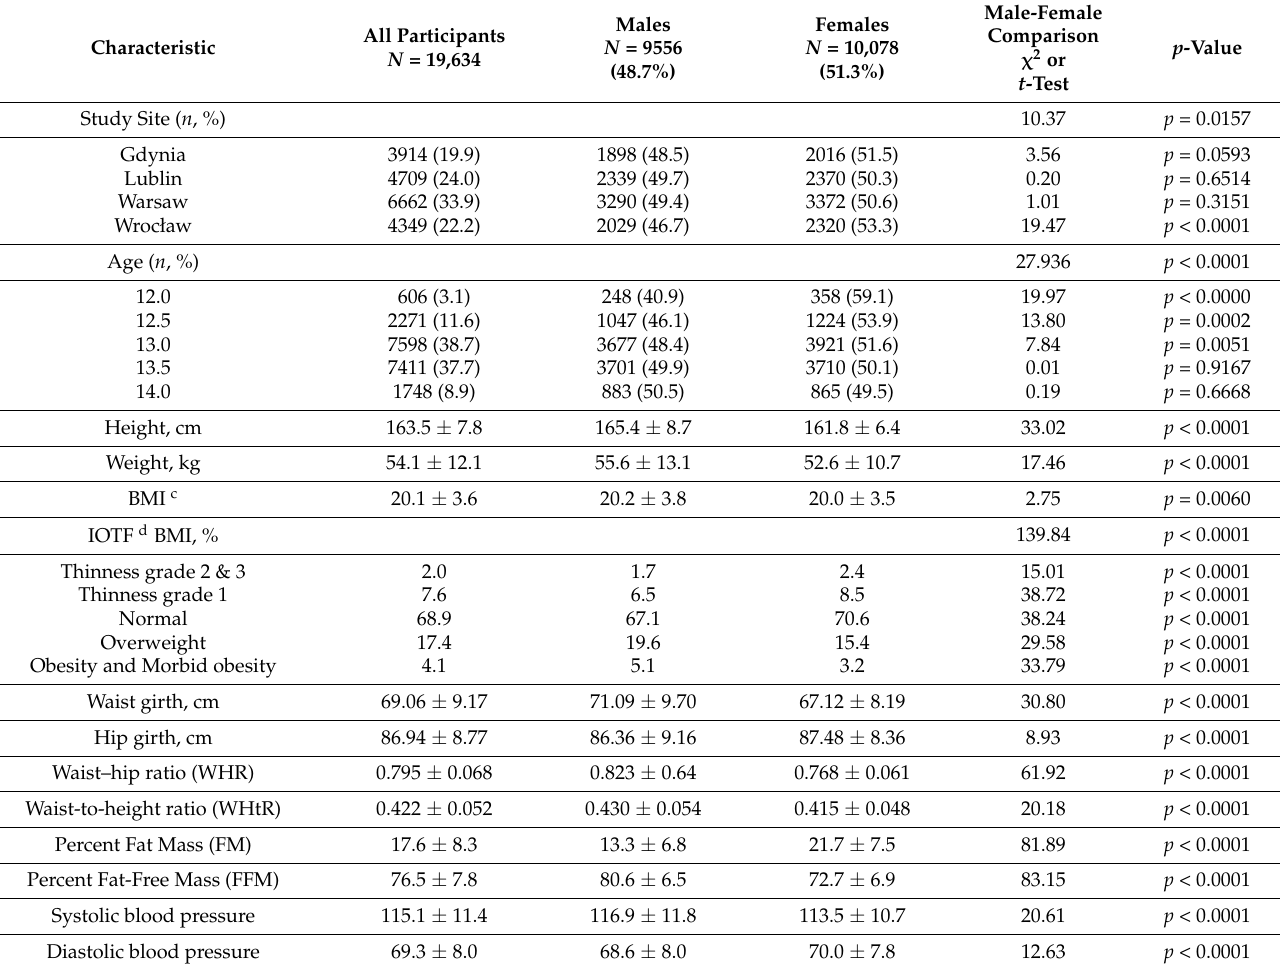
Table 1. Characteristics of the PoZdro Study Population a with sex-specific analyses b